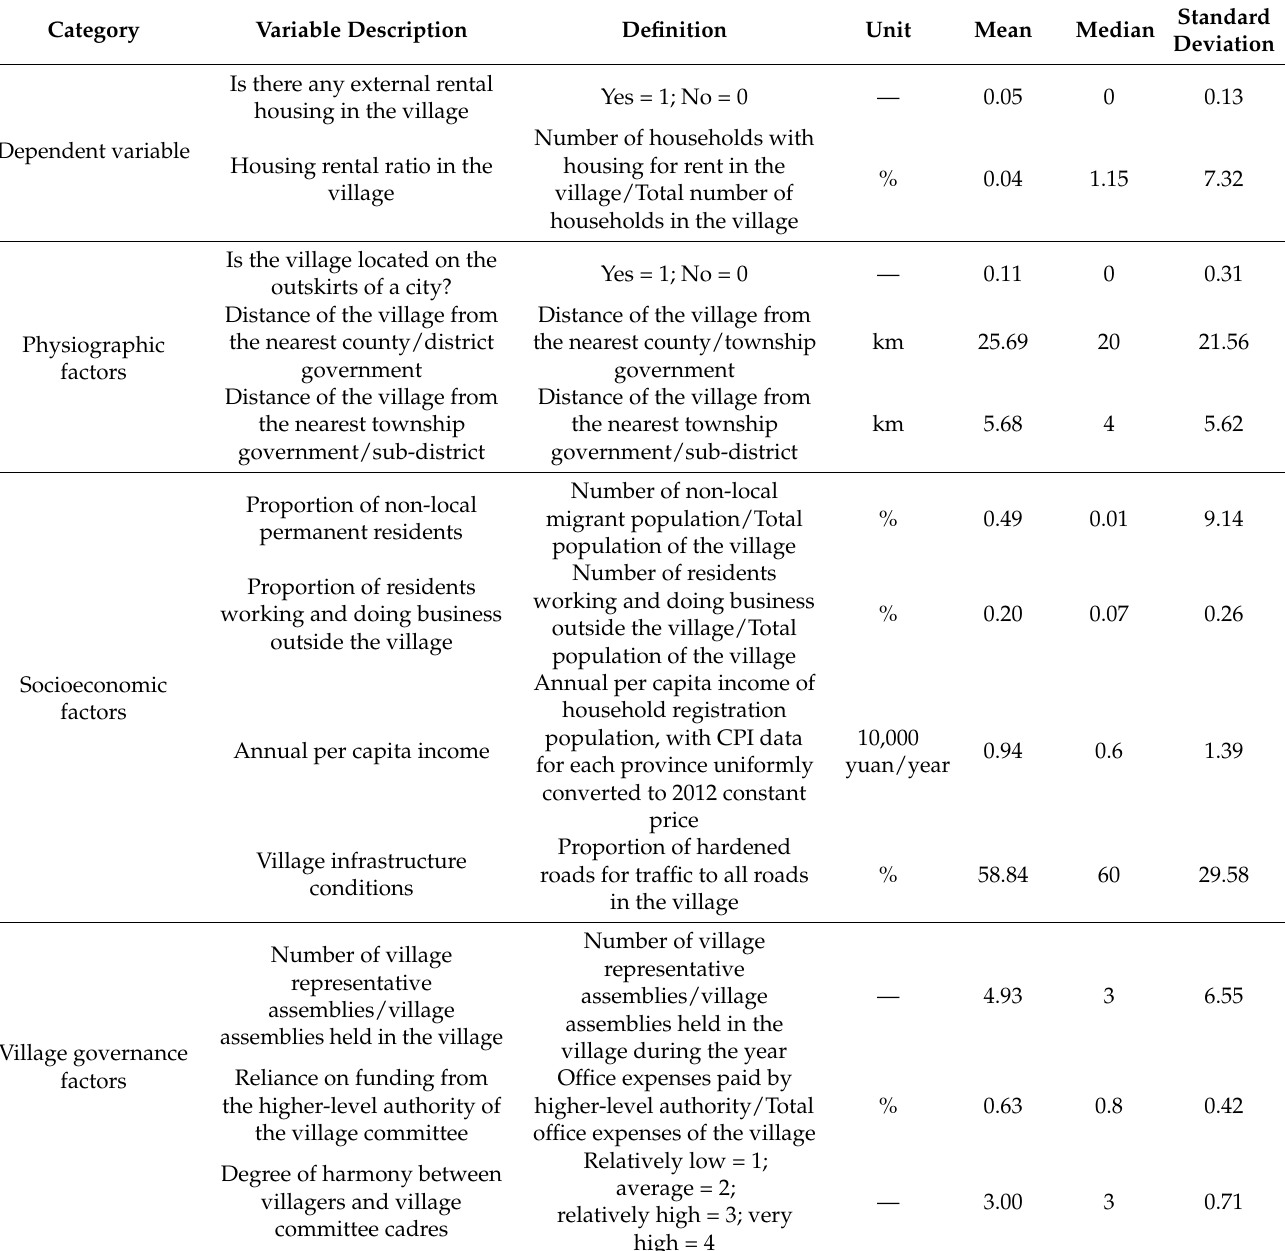
Table 1. Definitions and descriptive statistics of the study